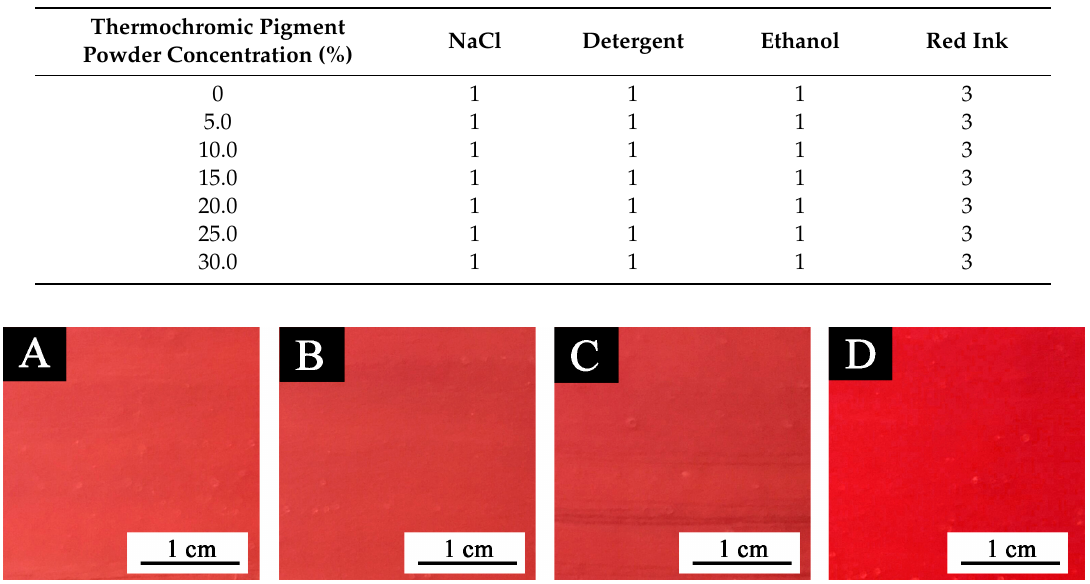
Figure 2. Images of coatings with 10% thermochromic pigment powder after liquid resistance test: ( A ) NaCl, ( B ) detergent, ( C ) ethanol, and ( D ) red